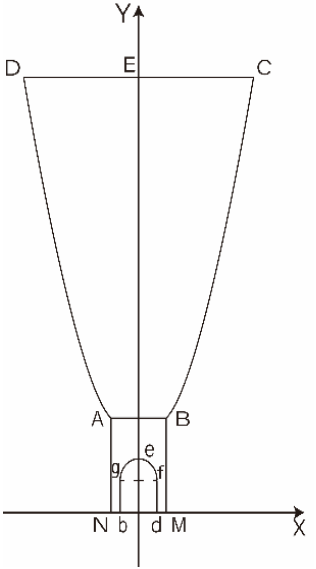
Figure 6. Axial section structure drawing of concentrator.